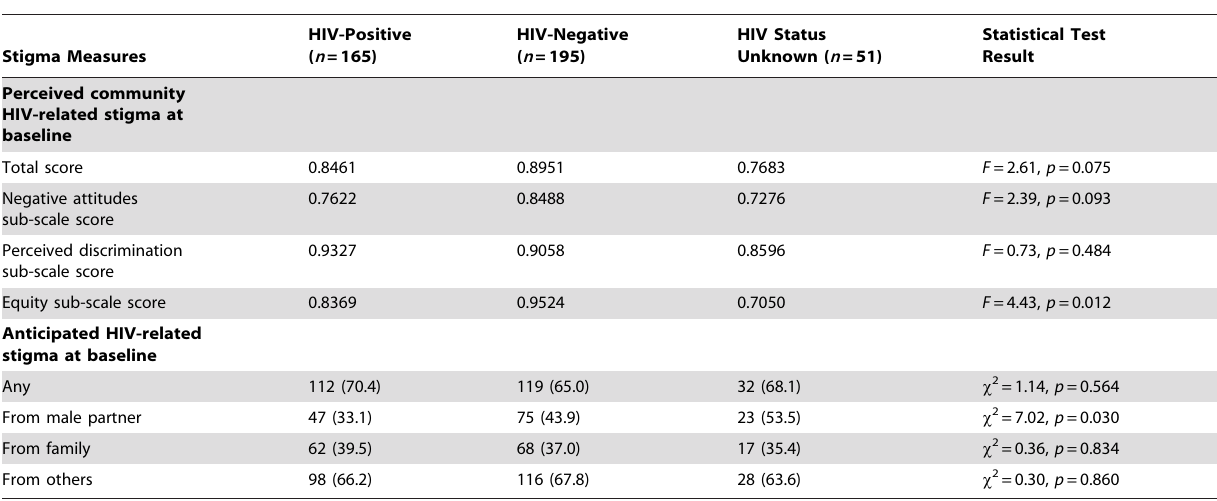
Table 2. Baseline perceptions of HIV-related stigma by HIV status at the time of the postpartum questionnnaire ( n =